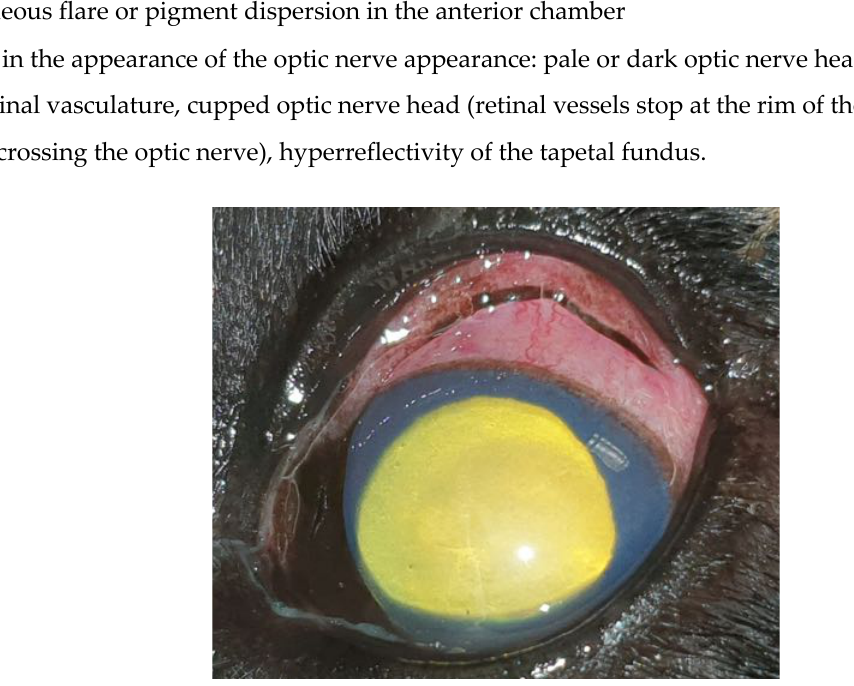
Figure 5. 8y6mo Cocker spaniel, FN with primary angle closed glaucoma – note the mucoid discharge at the medial canthus, third eyelid protrusion, moderate conjunctival hyperaemia, episcleral congestion, diffuse corneal oedema and dilated pupil (North Downs Specialist